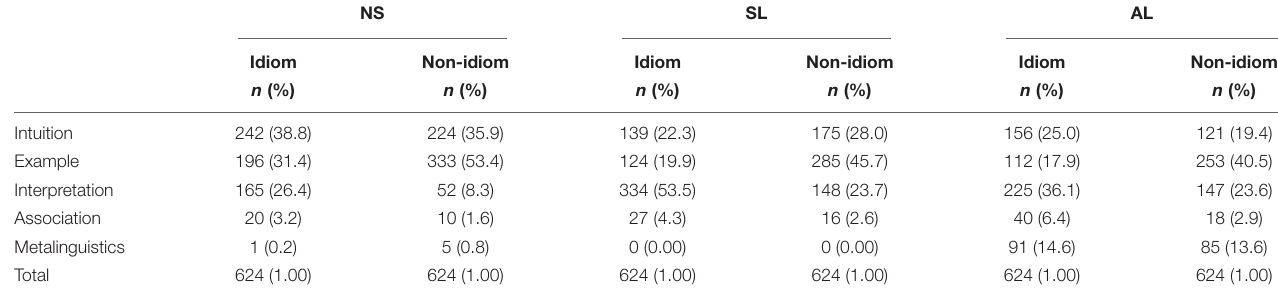
FIGURE 1 | Frequencies of strategy use by group. TABLE 5 | Crosstabulation of strategy by group and